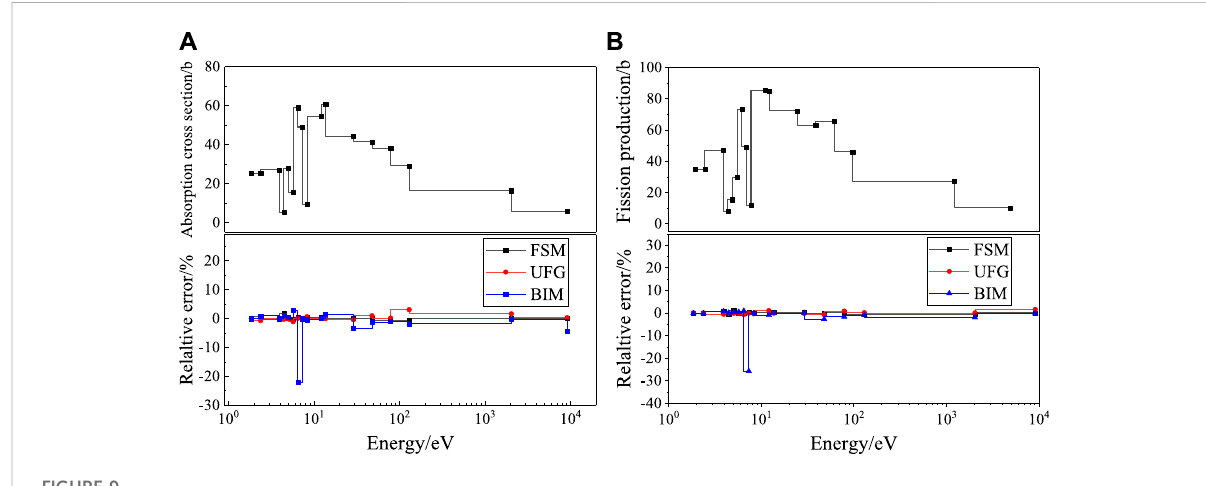
FIGURE 9 Relative deviation of the cross-section for 235 U for the 75 wt% case: (A) absorption; (B) fi ssion production.